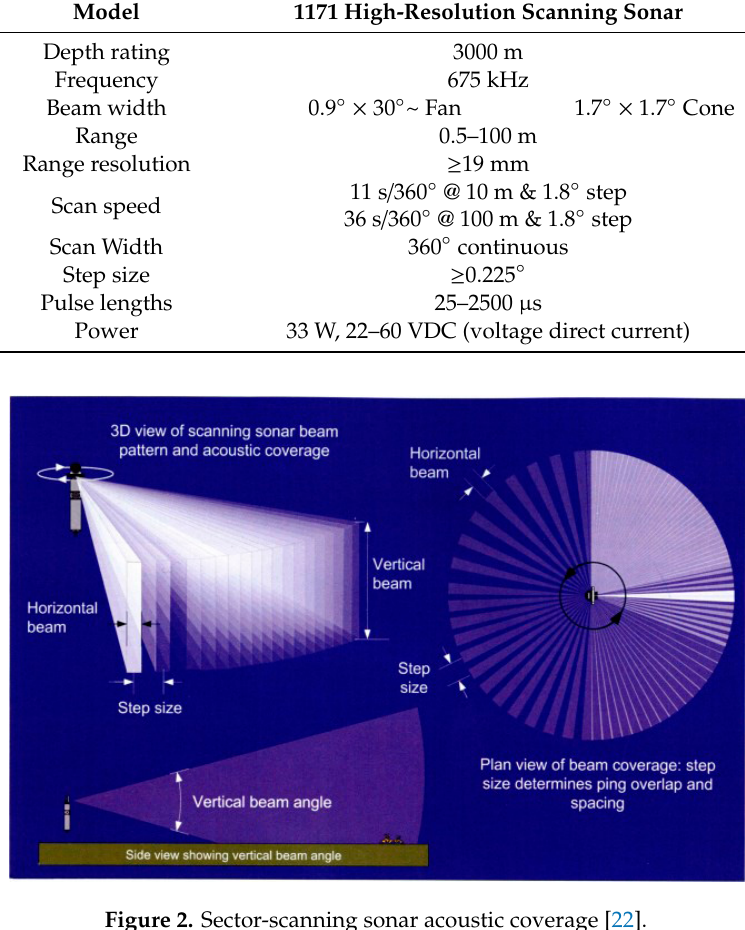
Figure 2. Sector-scanning sonar acoustic coverage [22].